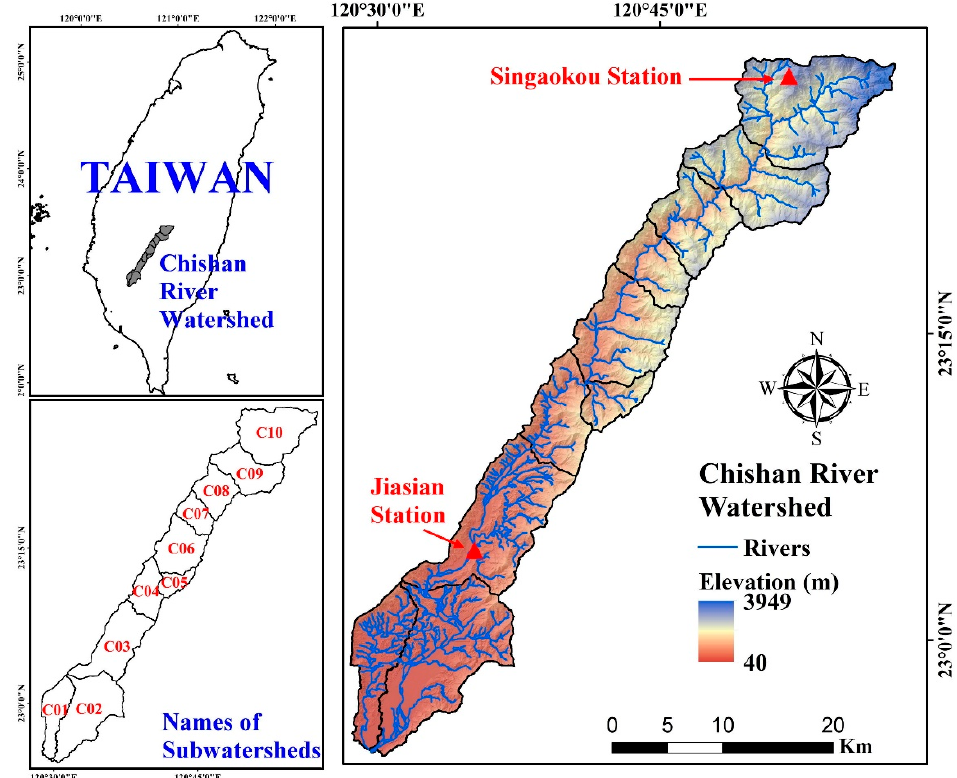
Figure 1. The distributions of elevation, rivers (main plot), and subwatersheds (left-down plot) in the Chishan river watershed.